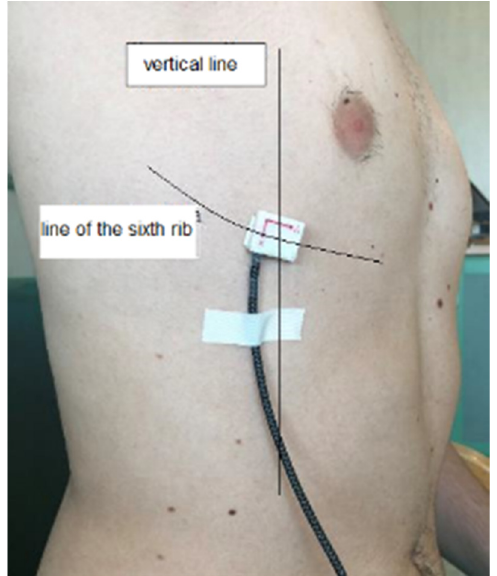
Figure 5. The IMU sensor unit of SENSIRIB on the sixth rib of a volunteer for a